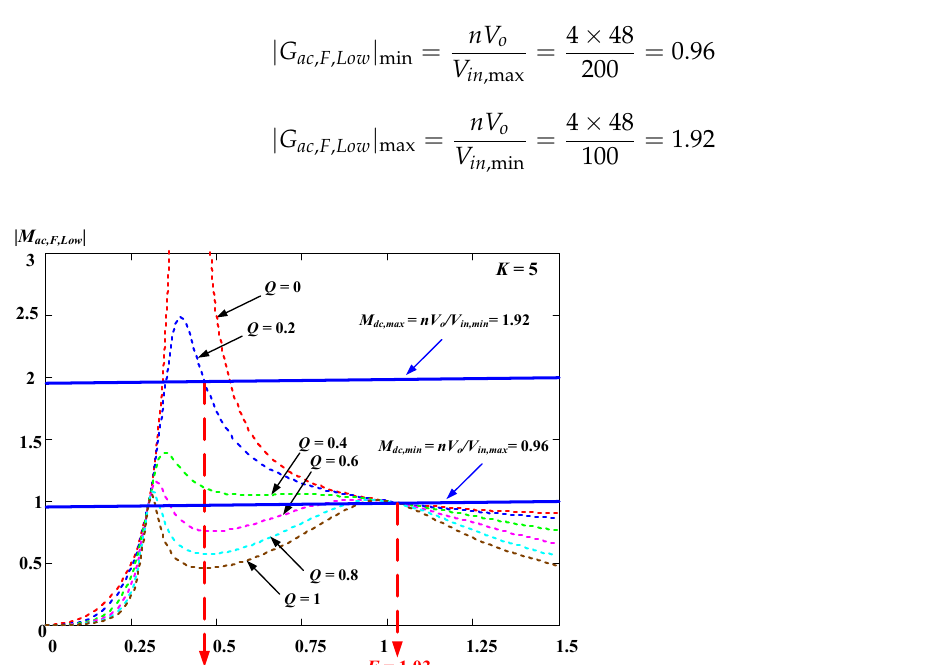
Figure 10. Gain curves of the prototype circuit under low input voltage range and forward power flow.